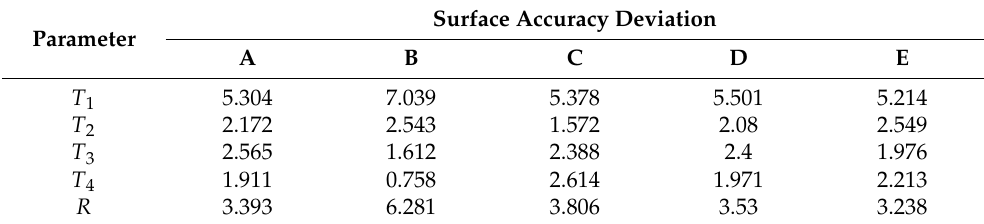
Table 5. Range analysis of surface accuracy deviation.